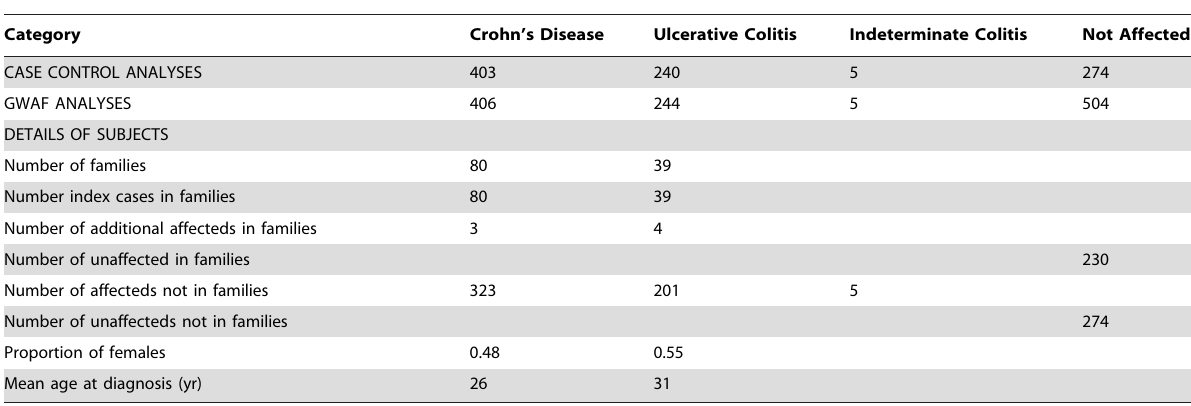
Table 1. Description of study